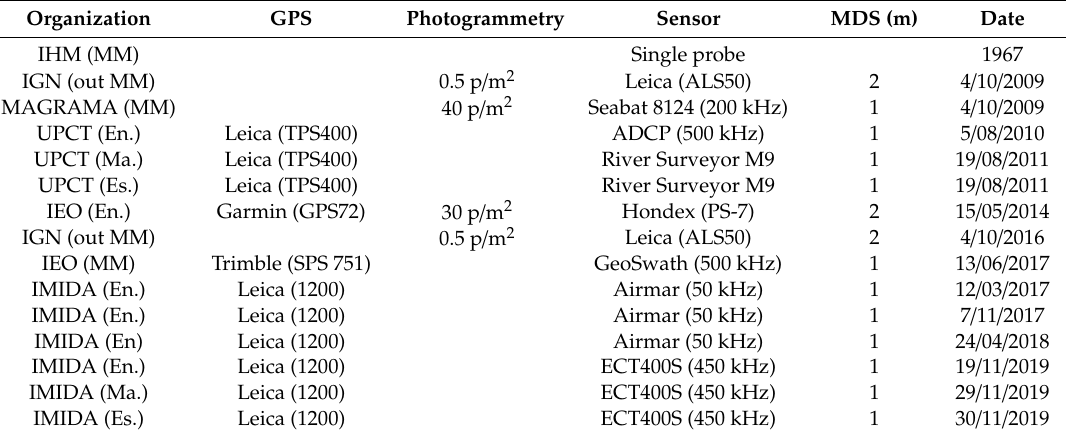
Table 1. Dates and characteristics of the field data used in the study of the channels.